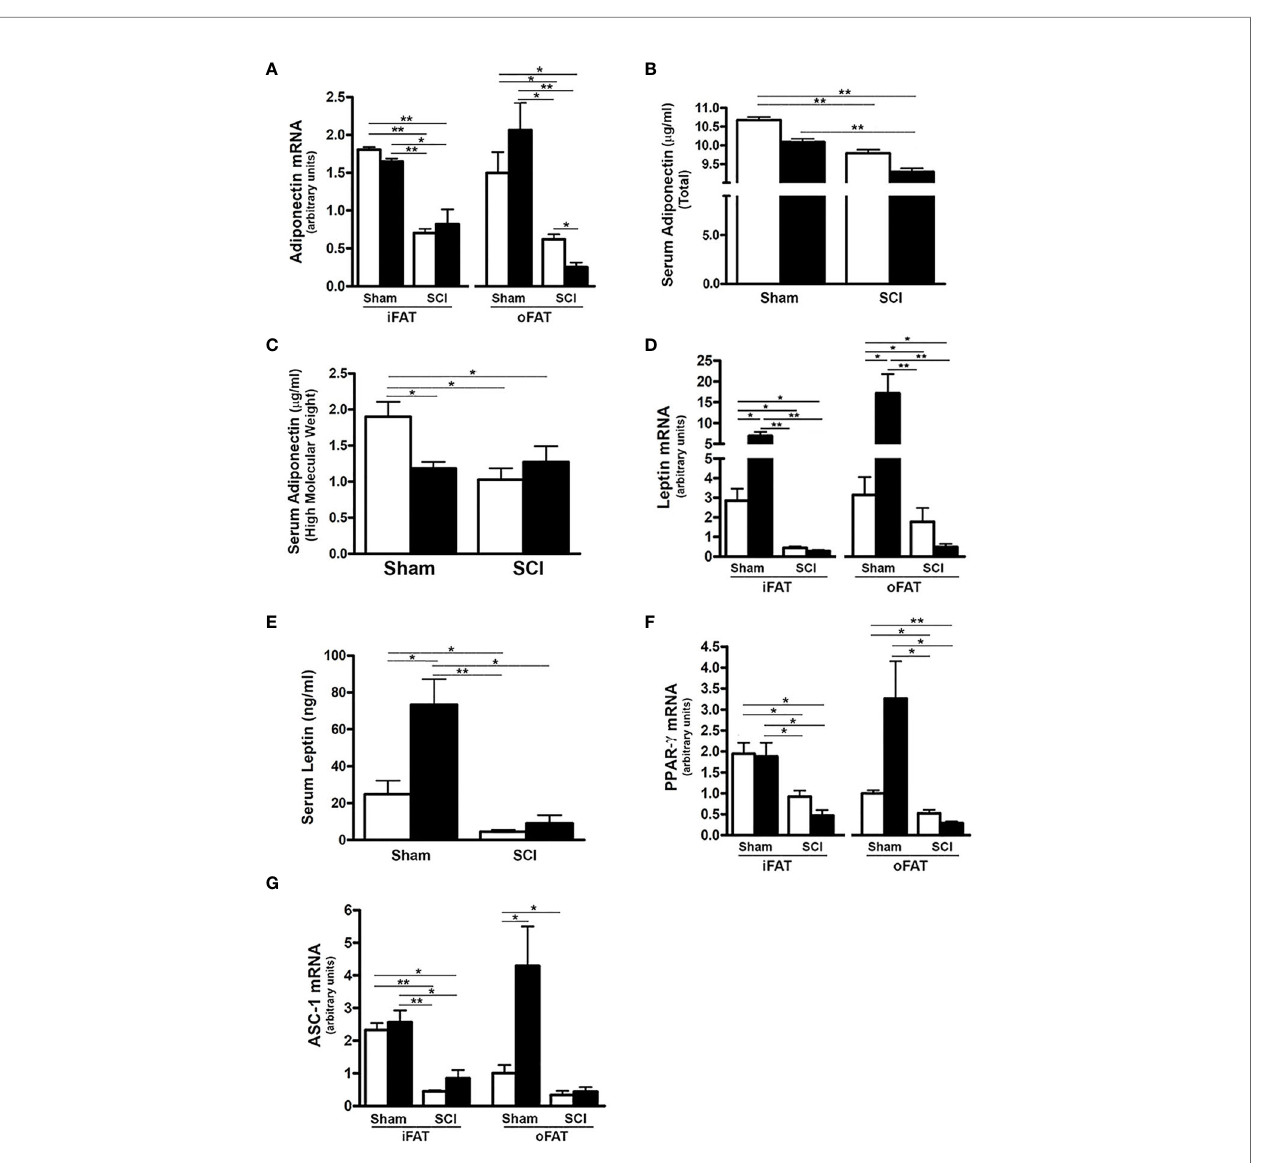
FIGURE 2 | Effects of SCI and HFD on Gene Expression of Adipokines and Differential Markers in Mouse Adipose Tissue. Mice were fed with either ConD (White Bar) or HFD (Black Bar) after surgery. Total RNA was isolated from mouse adipose tissues and subjected to Rt-PCR analysis for (A) , adiponectin mRNA expression; (B) , serum total adiponectin levels measured by ELISA; (C) , serum HMW adiponectin levels measured by ELISA; (D) , leptin mRNA expression; (E) , serum leptin secretion measured by ELISA; (F) , PPAR g mRNA expression; and (G) , ASC-1 mRNA expression. Data shown are mean values ± SEM (n = 5). * p < 0.05; ** p <